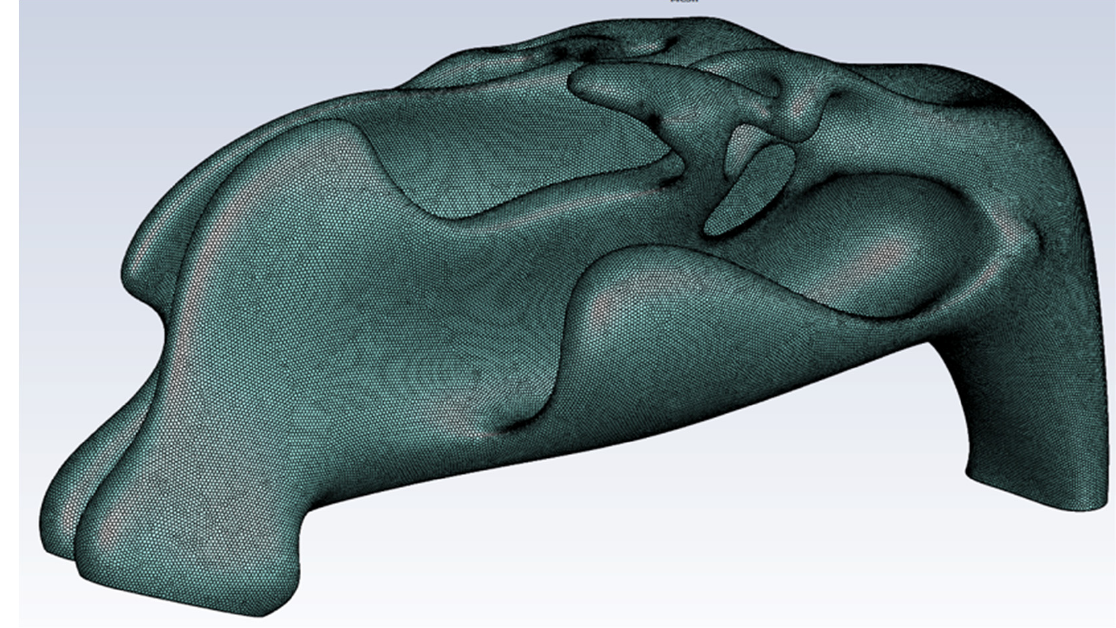
Figure 2. 3D model of the nasal cavity.